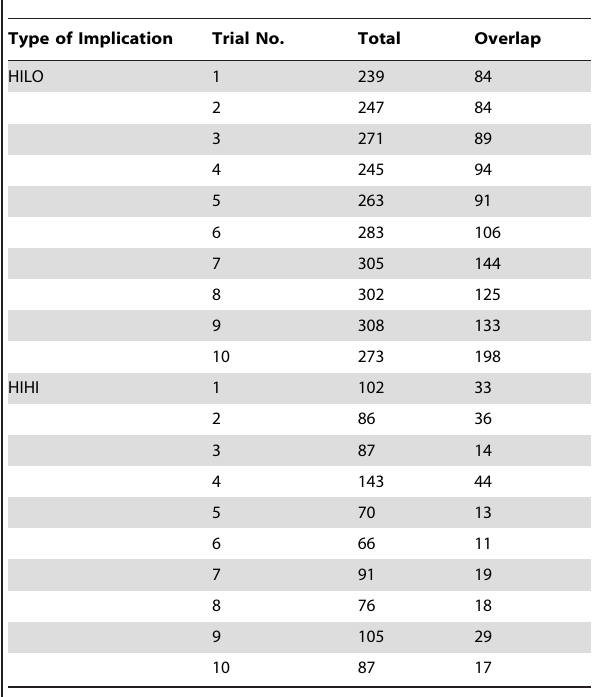
Table 5. Boolean implications versus Fisher’s exact test.